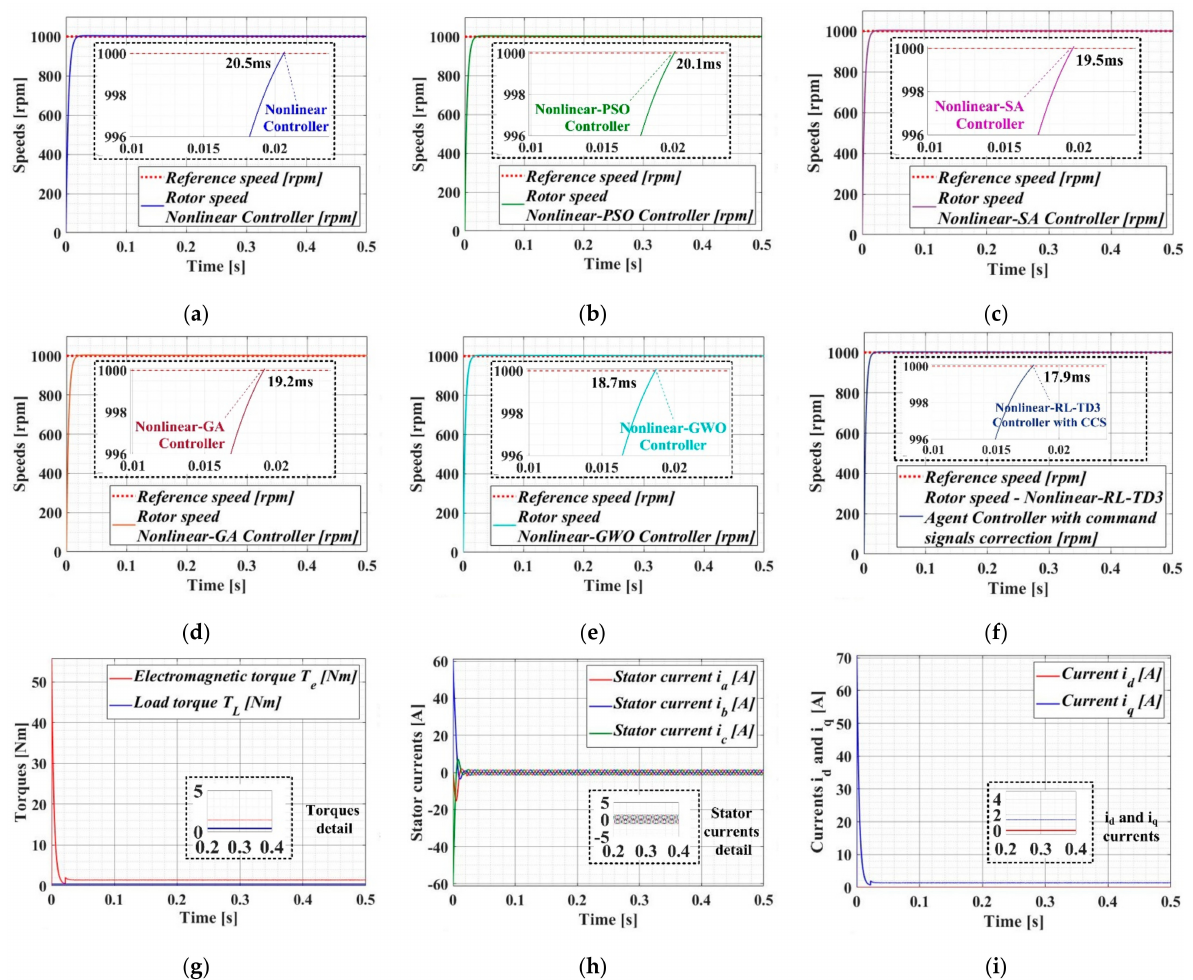
Figure 18. Time evolution parameters of the PMSM–CS–CI based on the nonlinear-type controller: ( a ) rotor speed—nonlinear; ( b ) speed—nonlinear–PSO; ( c ) speed—nonlinear–SA; ( d ) speed—nonlinear– GA; ( e ) speed—nonlinear–GWO; ( f ) speed—nonlinear–RL–TD3 with CCSs; ( g ) electromagnetic and load torques; ( h ) stator currents i a , i b , and i c ; ( i ) currents i d and i q .